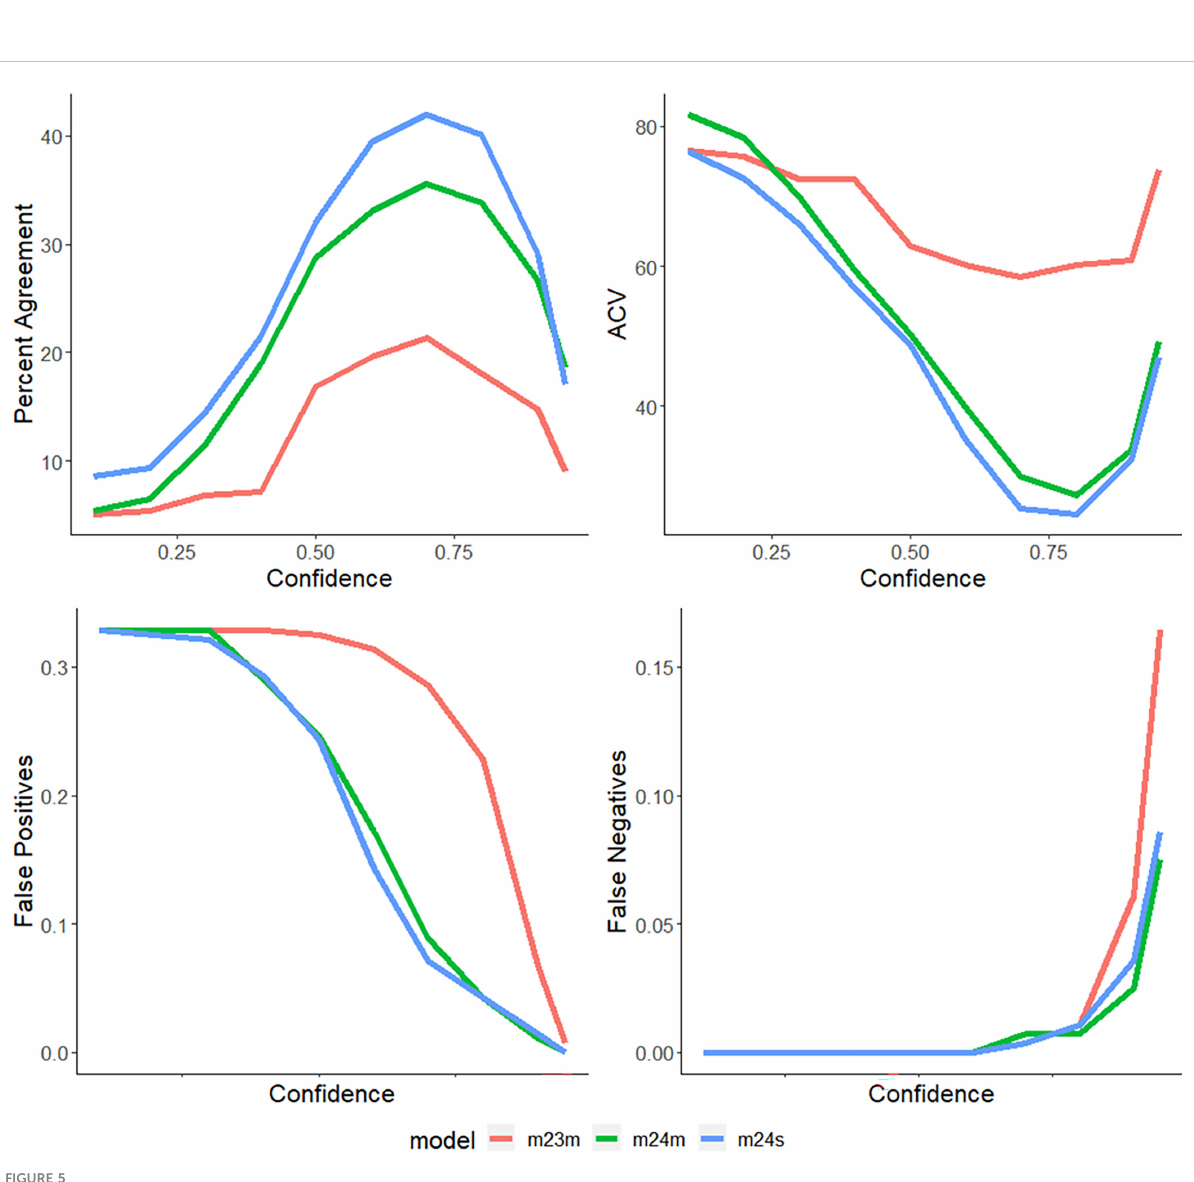
FIGURE 5 Percent agreement, ratio of false-positive detections, ratio of false-negative detections, and CV values across all con fi dences (0.1-0.95) for models 2.3, 2.4m, and 2.4s for ( Lutjanus campechanus , the most observed species of the survey) with a maximum percent agreement of 42.03, and a minimum CV value of